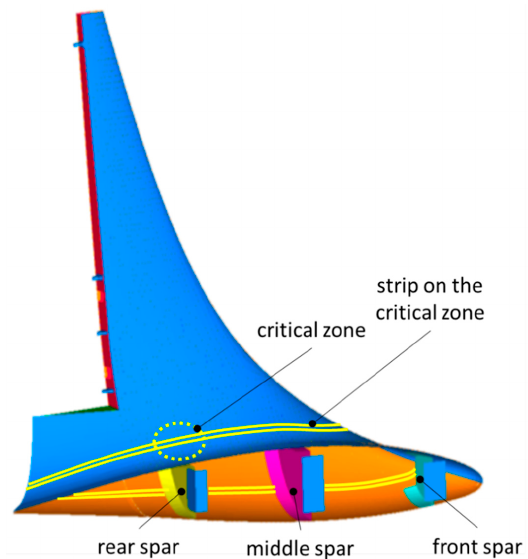
Figure 2. Finite element (FE) model of the winglet without the moveable surfaces [23]. For the analysis of the laminates, a maximum/minimum strain criterion in 11- and 22-direction is used. Additionally, stress is also evaluated in 11-, 22- and 12-directions. The ply stresses and strains are read from the FEM results. The failure indexes for each ply were then calculated. The enveloped results were then elaborated to allow for com- putation of the minimum failure index.